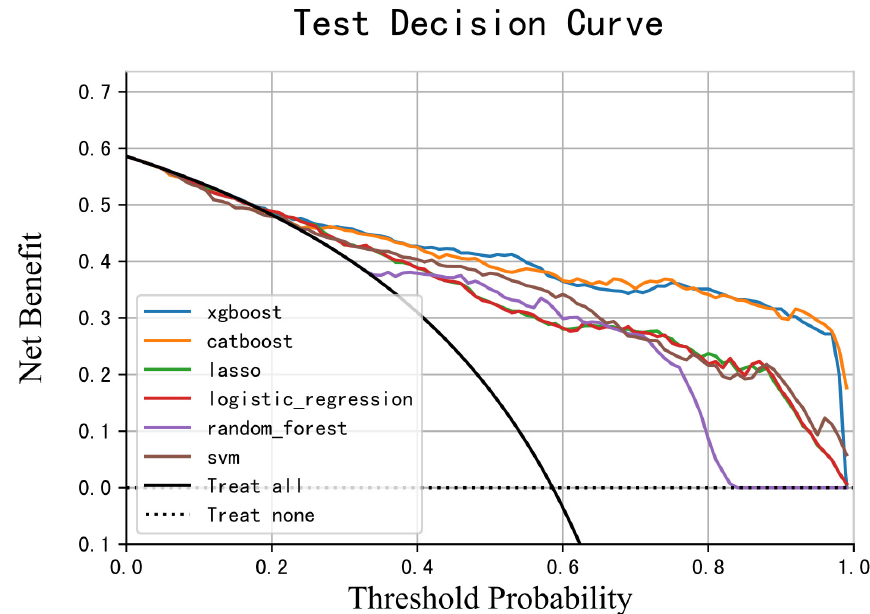
Figure 4. Calibration curves of the six ML models.